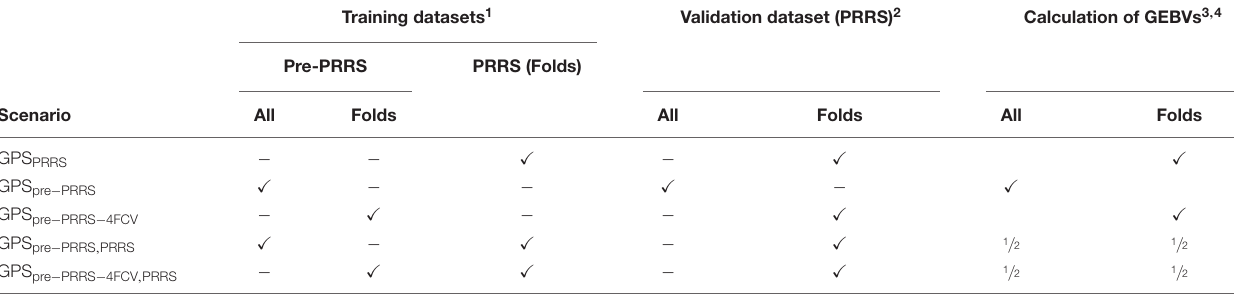
TABLE 2 | Summary of genomic prediction scenarios (GPS)